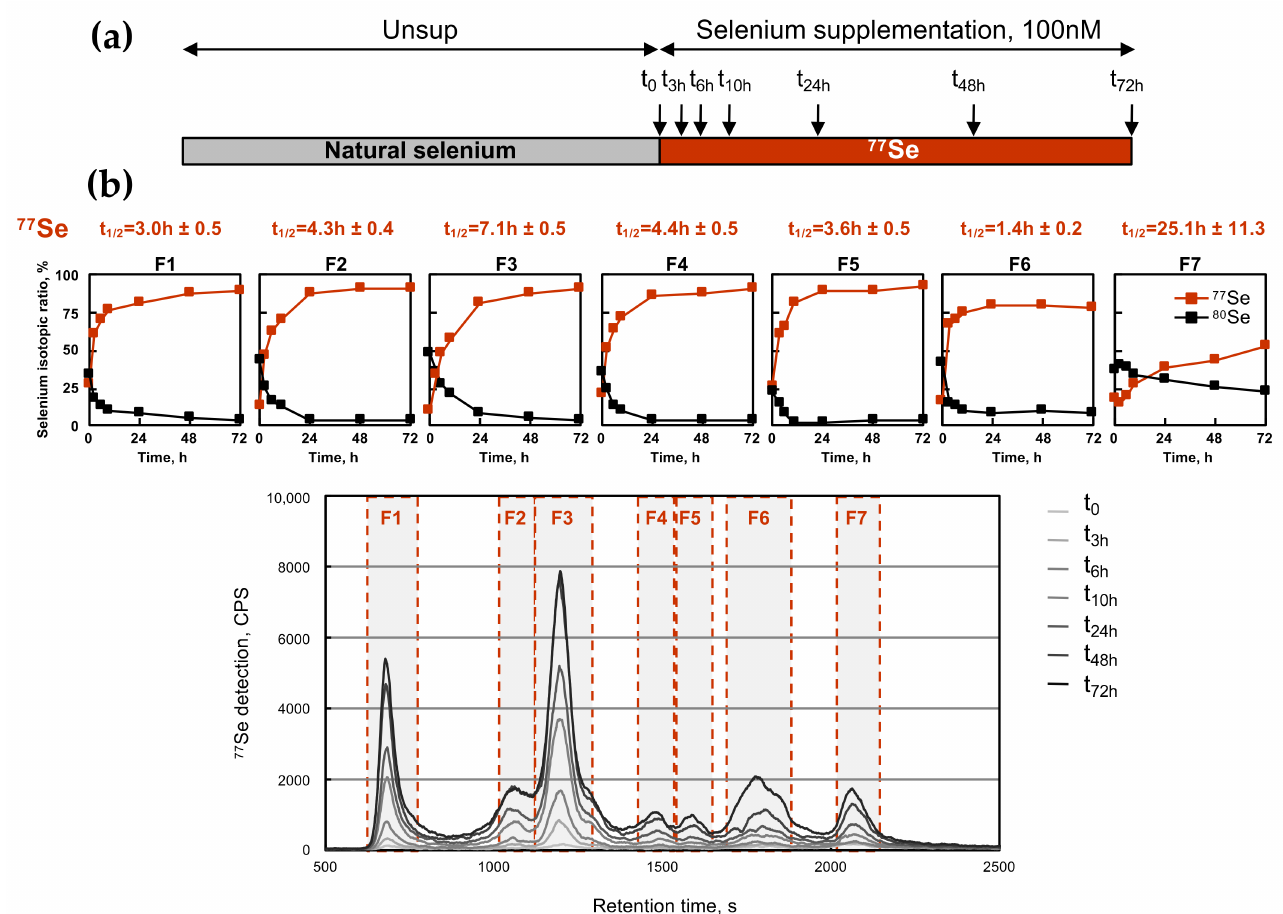
Figure 4. Time-course analysis of HEK193 cells labeled with 100 nM of 77 Se by SEC ICP MS. ( a ) Cells were grown for three days in a Dpl medium prior to being plated in fresh medium with 100 nM of 76 Se enriched selenium. Then, the cellular extracts were harvested at defined times post treatment (0, 3, 6, 10, 24, 48, and 72 h) and analyzed by SEC-ICP MS as described in Figure 2. ( b ) The chromatographic profile for 77 Se is shown in the bottom panel for the various cellular extracts. The isotopic pattern was analyzed in the seven identified fractions, as indicated by dashed boxes (F1 to F7). Only 77 Se and 80 Se are represented in red and black squares, respectively. The kinetics for 77 Se abundance in each fraction as a function of time were fitted as described in experimental procedures. The results of t 1/2 for 76 Se labeling are indicated on top of respective graphs.